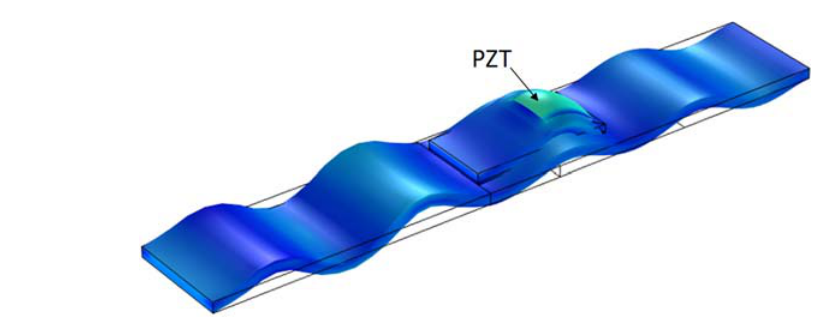
Figure 5. The finite element model of the beam equipped with a single-point mount PZT interface. Table 1. Mechanical properties of the aluminum [35]. Parameters The Interface and the